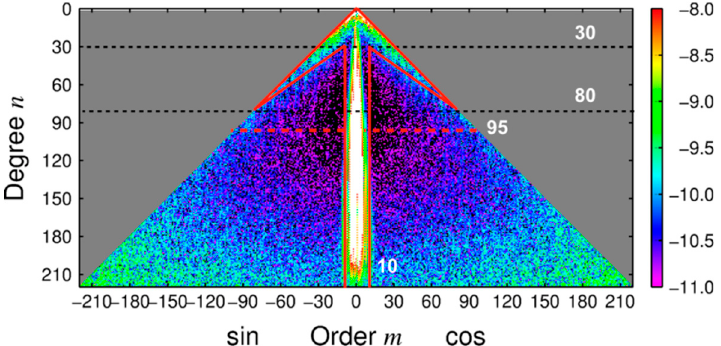
Figure 2. Error spectra of the recovered spherical harmonic (SH) coefficients in log10 scale compared to EGM2008.